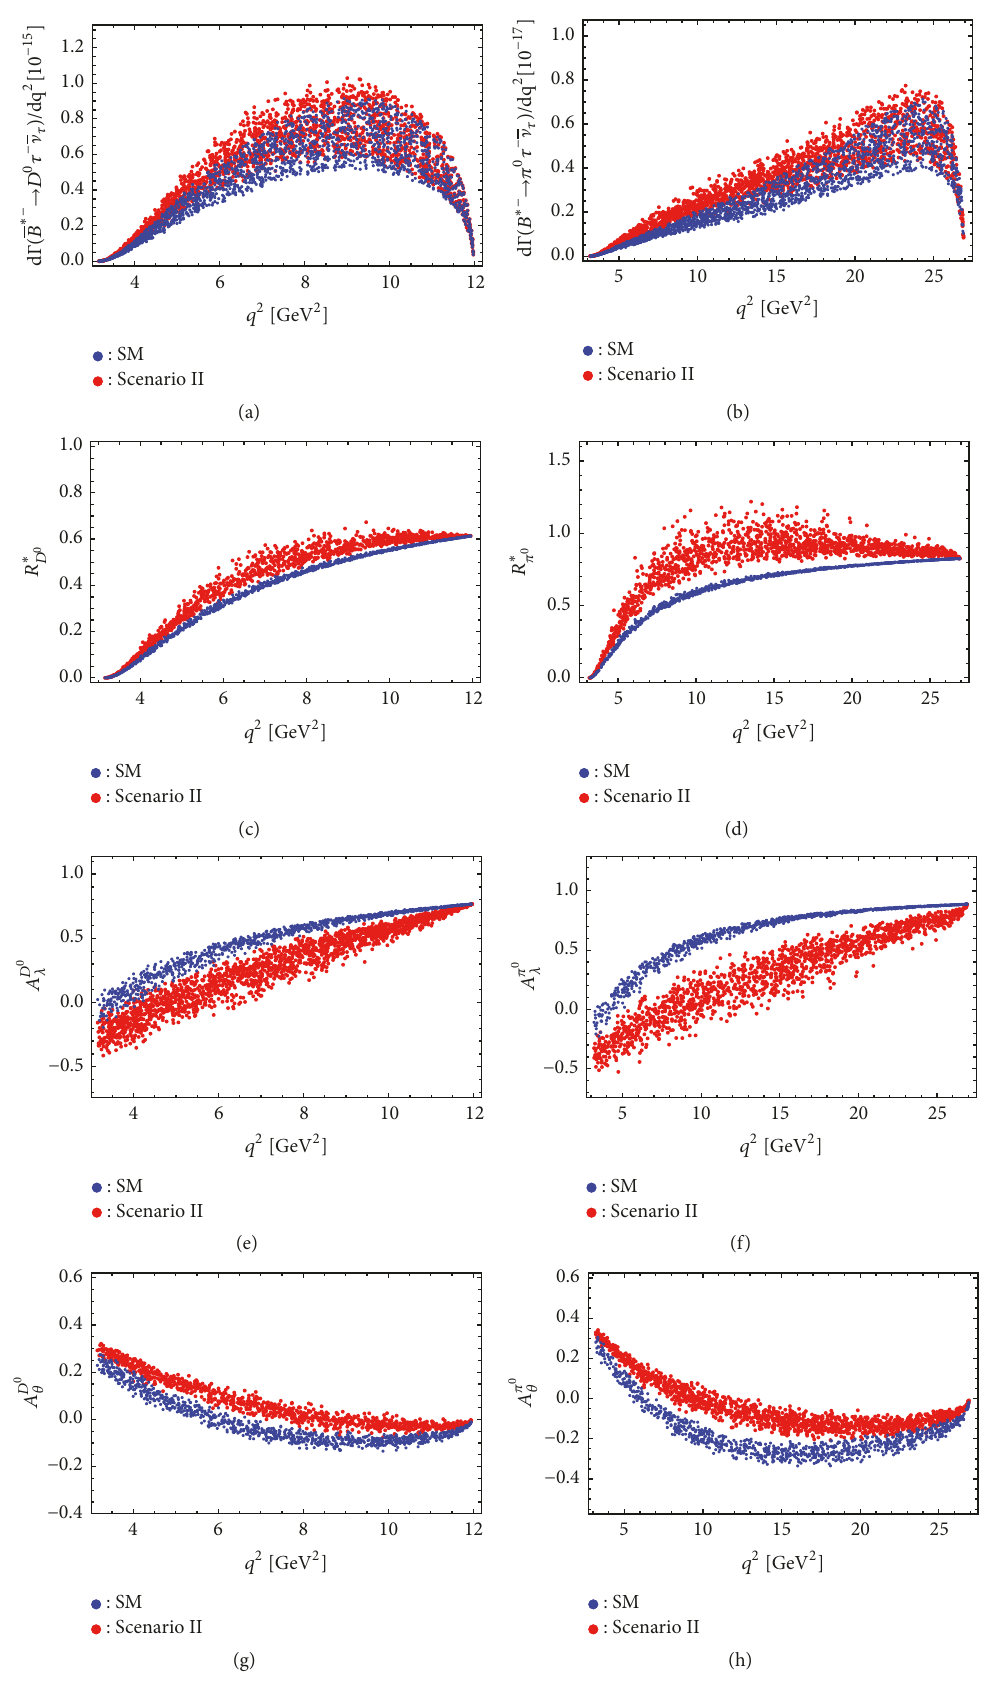
Figure 4: The 𝑞 2 -dependence of the differential observables 𝑑Γ/𝑑𝑞 2 , 𝑅 ∗ 𝑃 , 𝐴 𝑃 𝜆 , and 𝐴 𝑃 𝜃 for 𝐵 ∗− 󳨀→ 𝐷 0 𝜏 − ] 𝜏 and 𝜋 0 𝜏 − ] 𝜏 decays within the SM and scenario